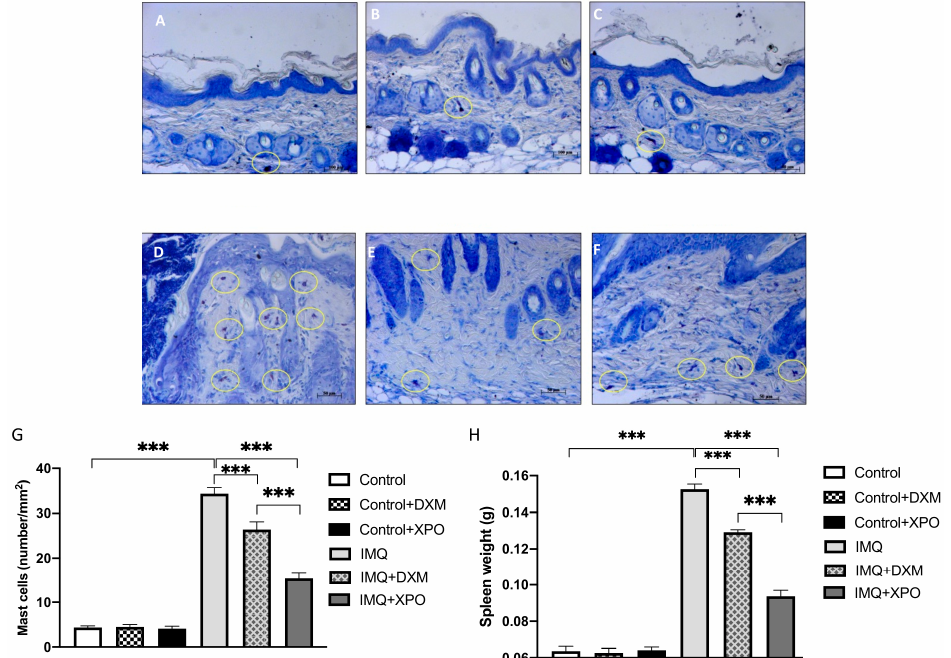
Figure 6. Effect of XPO cream on mast cell infiltration induced by imiquimod (IMQ) and spleen weight. Mice treated with IMQ displayed a significant increase in mast cell degranulation which was determined by toluidine blue staining (panels ( A – F )). XPO cream treatment significantly reduced the degranulation of mast cells (panel ( F )). See mast cell counts ( G ). Marked splenomegaly was diagnosed in the psoriatic mice ( H ), while a marked reduction in this systemic effect was evident following XPO treatment ( H ). *** p < 0.001.